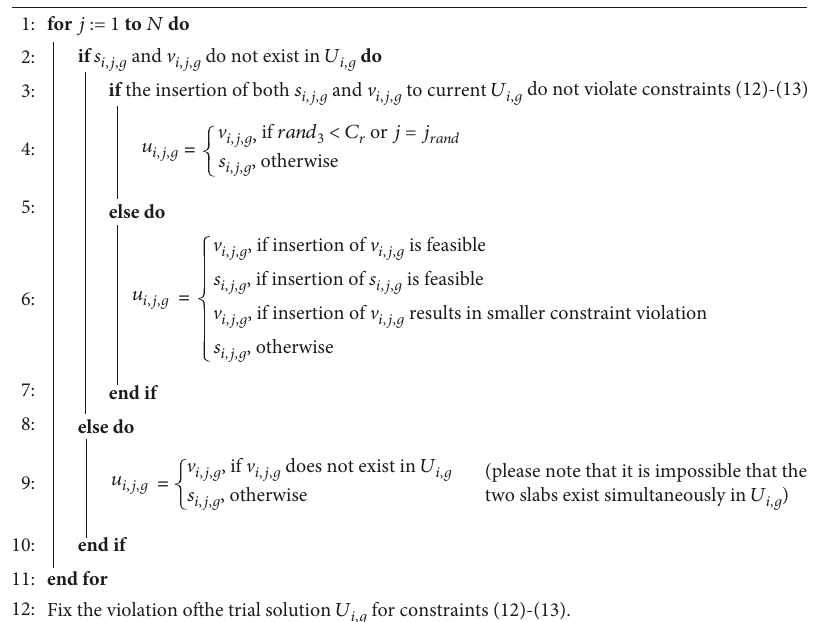
Figure 6: Procedure of the crossover operator with feasibility